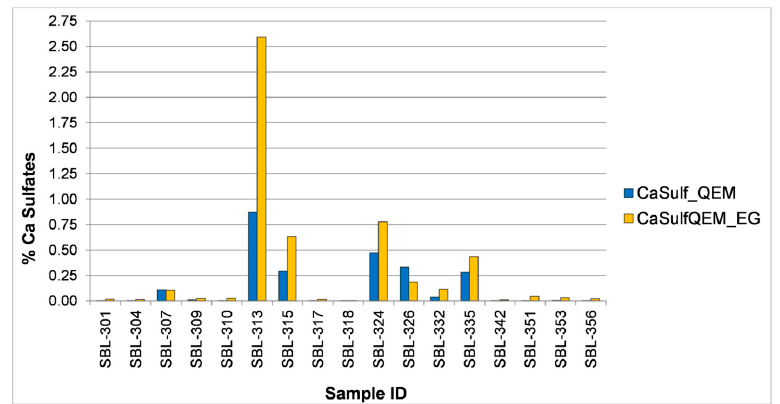
Figure 10. Comparison of the percentages of calcium sulfate minerals detected by QEMSCAN ® for sections polished with water (CaSulf_QEM) vs. ethylene glycol (CaSulfQEM_EG).